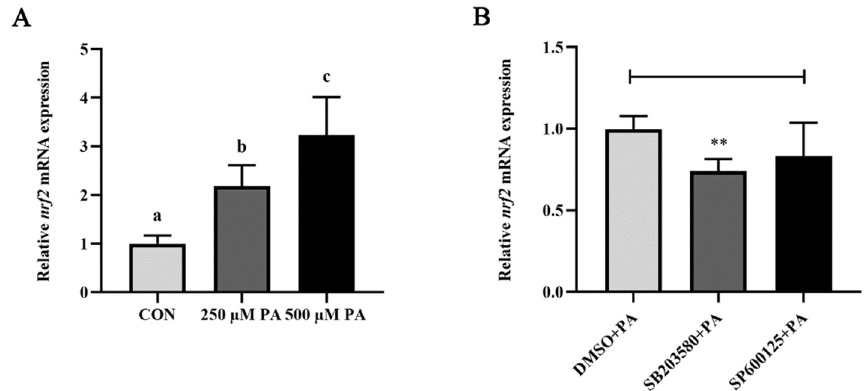
Figure 7. p38 MAPK regulated the PA-induced activation of Nrf2. ( A ) The mRNA expression level of nrf2 after PA treatment. ( B ) Effects of the p38 (SB203580) and JNK (SP600125) inhibitors on the mRNA expression level of nrf2 induced by PA. Data are presented as the means ± SEM ( n = 6) and analyzed using one-way ANOVA, followed by Tukey’s test and independent t -tests. Bars labeled with the same letters are not significantly different ( p > 0.05 and ** p < 0.01).